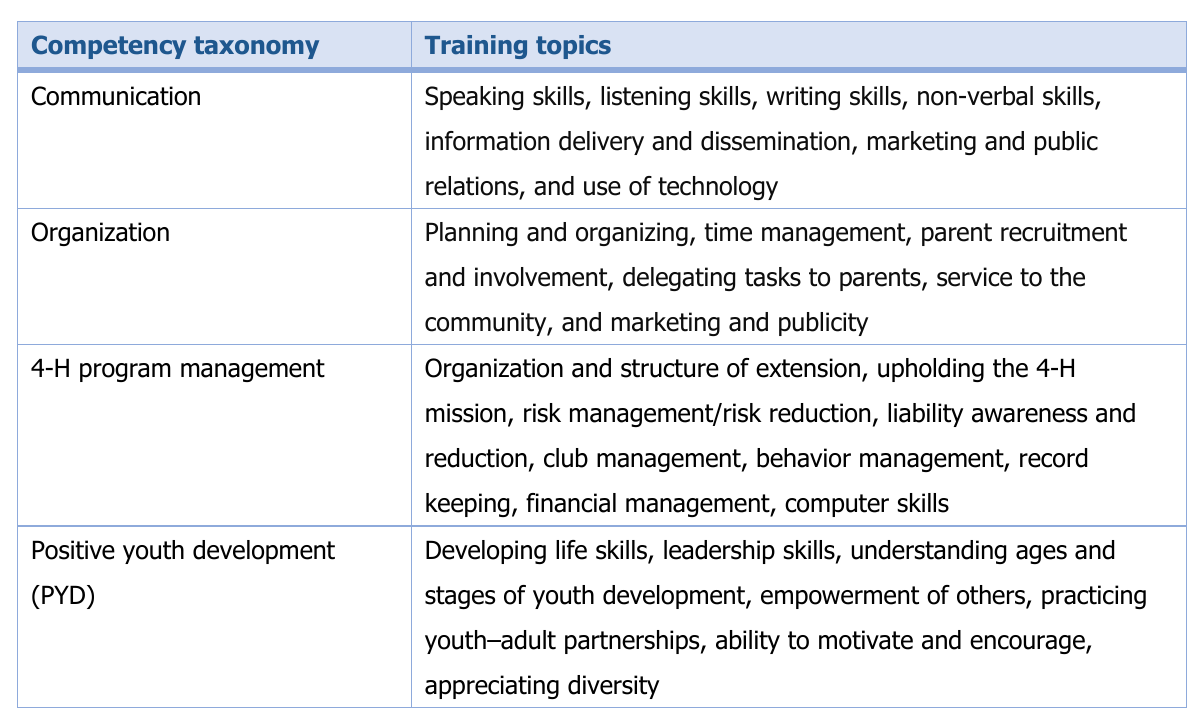
Table 6. Lesson Plans and PowerPoints Available for 4-H Volunteer Managers to Train Volunteers on Topics Related to the Prioritized Competency Areas From this Study (National 4-H Council,